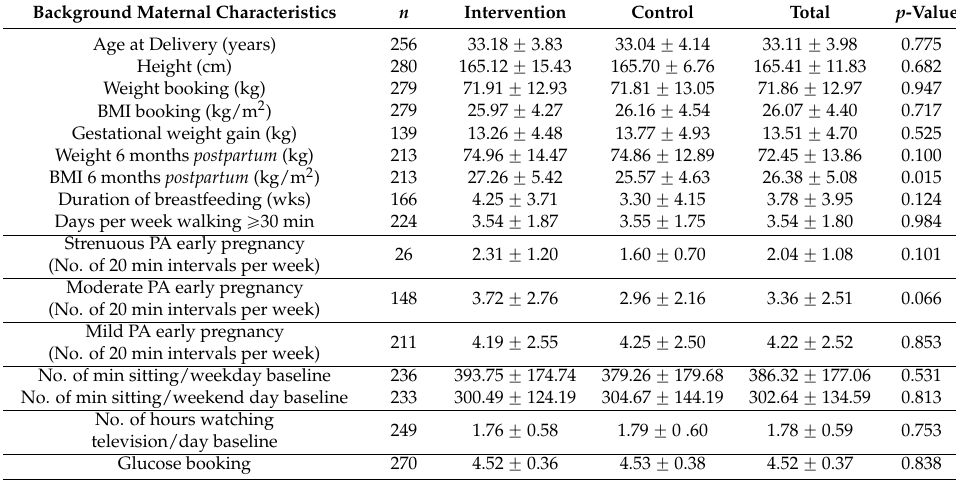
Table 1. Maternal characteristics during pregnancy and at 6 months and comparison of control and intervention (low glycaemic index diet)